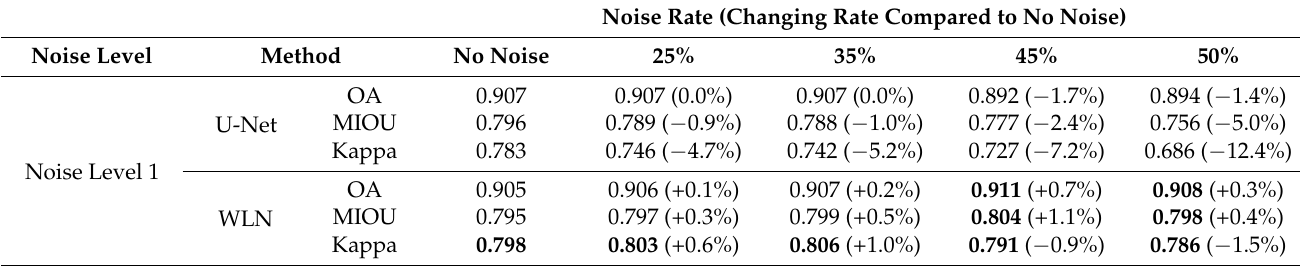
Table 2. Comparison of the performance of WLN and U-Net with eroded